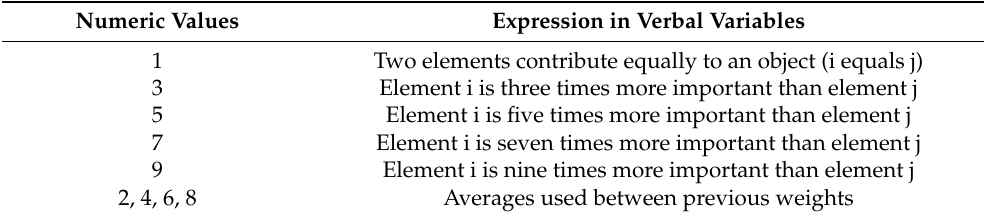
Table 2. Relative importance weights for pairwise comparison. Numeric Values